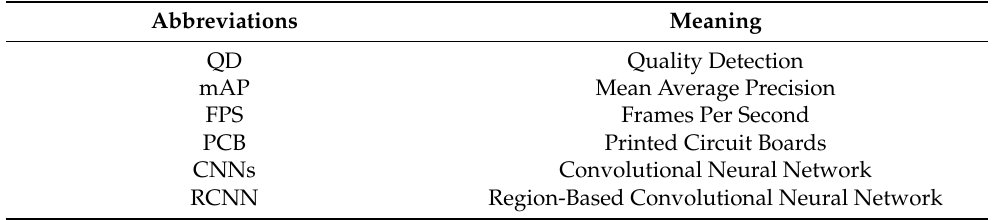
Table 2. The abbreviations used in this